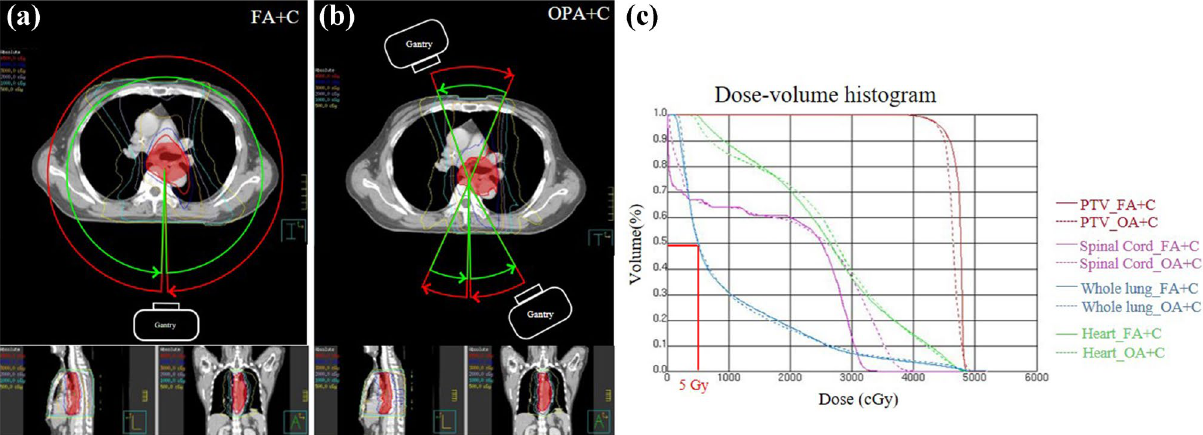
Figure 3. The isodose curves and DVH of VMAT plans for a patient. For this patient, the OPA angle was 110°. ( a ) Isodose curves of FA + C plan. ( b ) Isodose curves of OPA + C plan. ( c ) DVH for FA + C and OPA + C plan. The gantry arc angles were shown in ( a ) and ( b ). The red arcs were counterclockwise (CCW) direction. The green arcs were clockwise (CW) direction. The FA plans used two full arcs. The OPA plans used six partial arcs. The red line means the relative lung volume receiving more than 5 Gy (V 5 ) in DVH of ( c ).